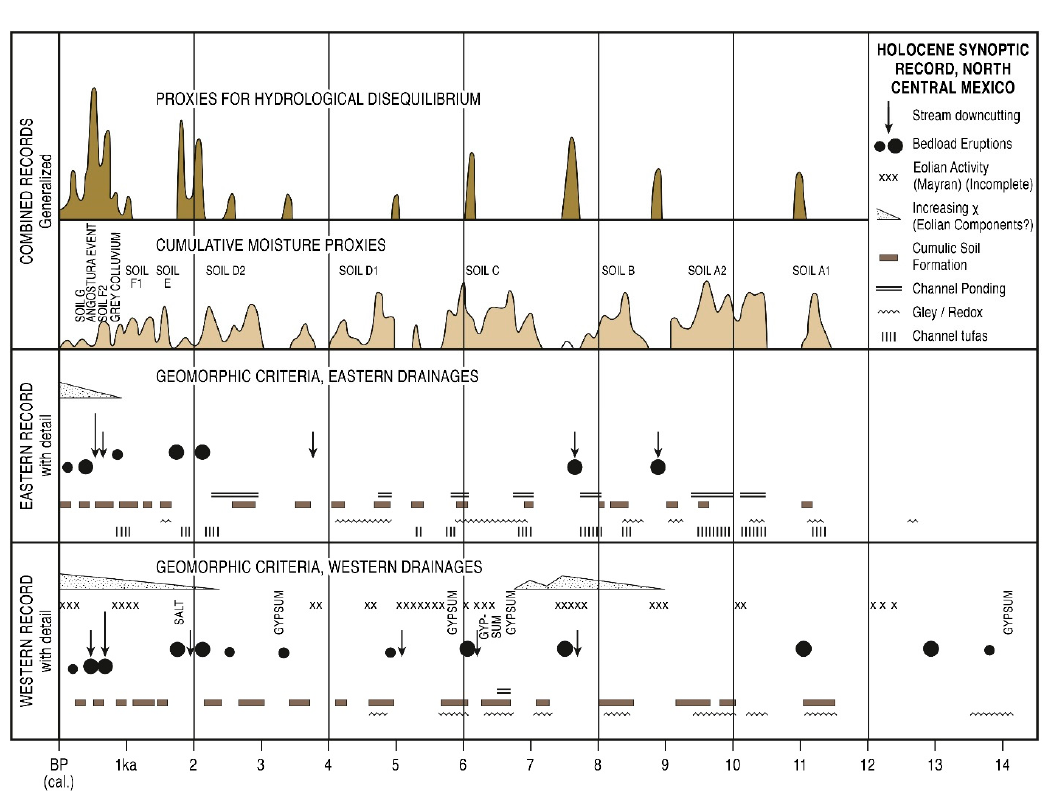
Figure 13. Holocene wet cycles according to the Laguna Project sedimentology data of all examined sites; see Figure 1 (modified from [13]). However, after a final wet period circa the 2800 BP wet phase with high tree pollen,